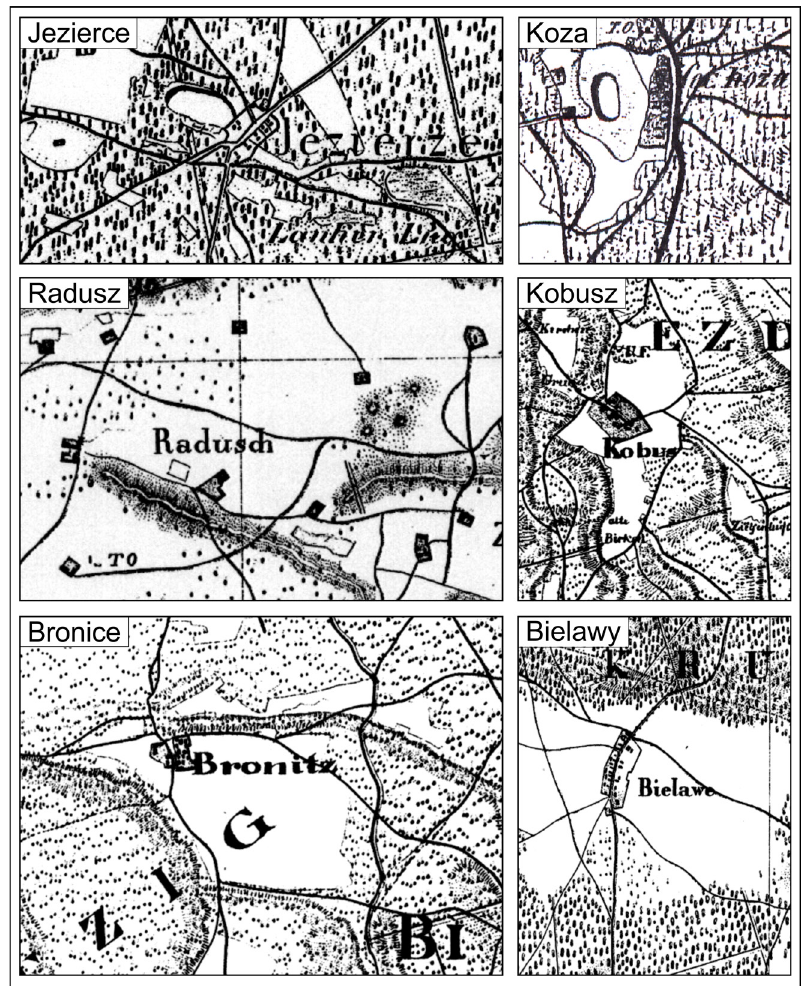
Fig. 2. Parts of Urmesstichblatter von Preussen maps from 1832–1833 covering selected parts of research